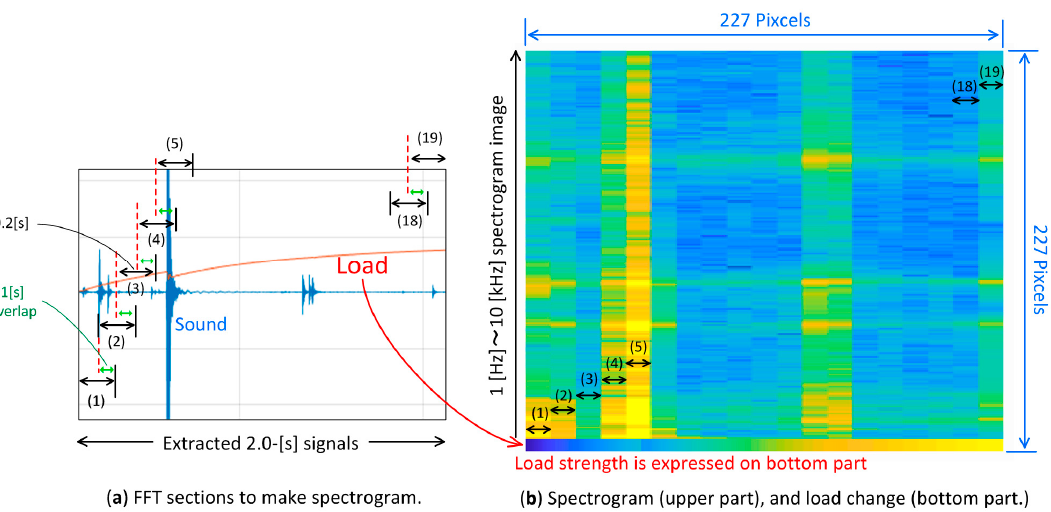
Figure 16. Calculation of input image to CNN: ( a ) FFT (Fast Fourier Transform) period and ( b ) spectrogram and load change image.